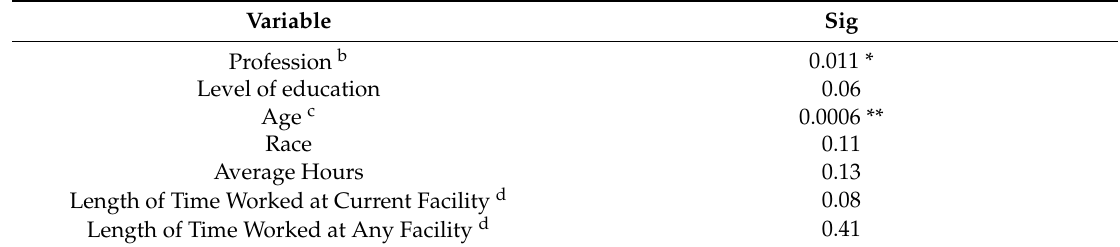
Table 5. Change commitment a